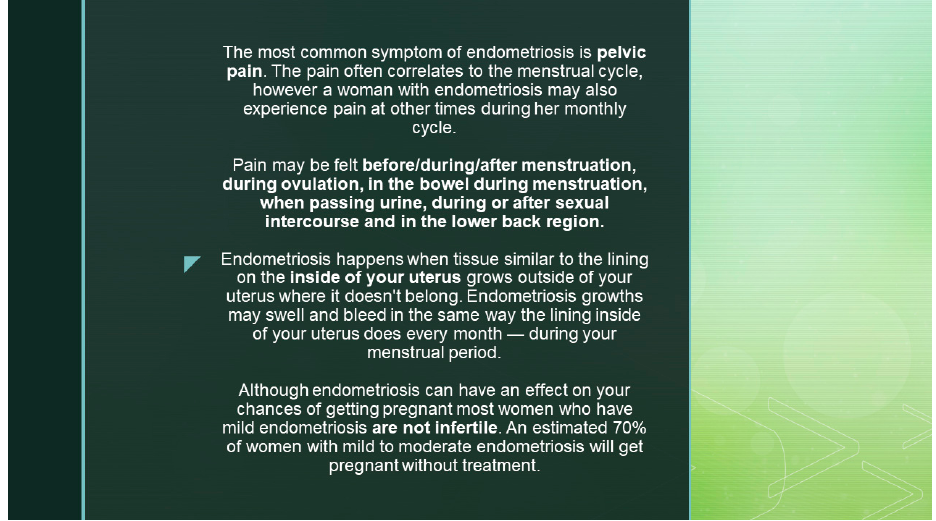
Figure 1. Educational brochure on endometriosis.